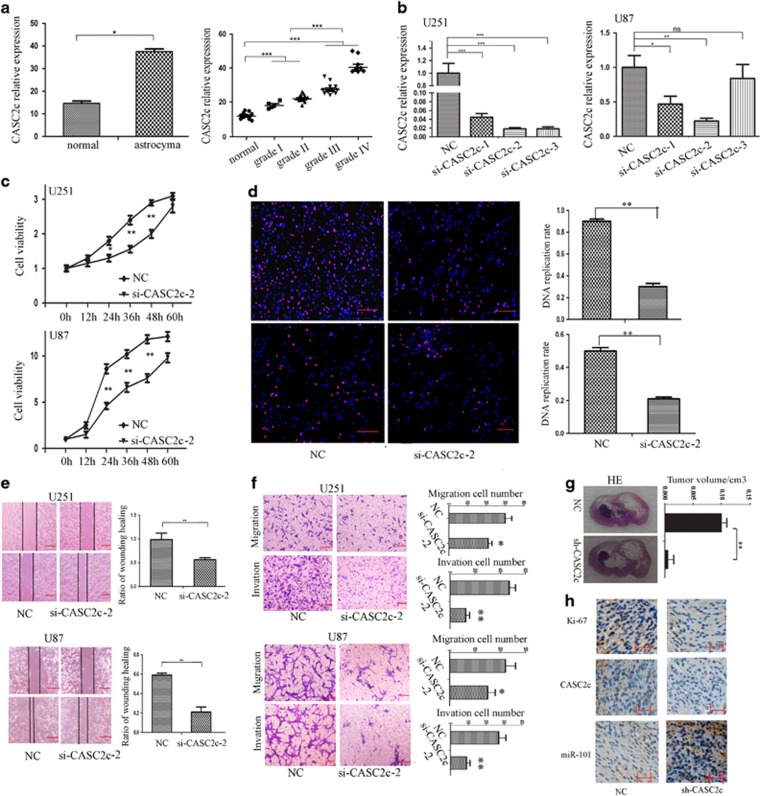
CASC2c is correlated with tumorigenicity and progression in astrocytoma. (a) Left, the expression of CASC2c in normal brain tissues and astrocytoma was determined by real-time qPCR. Data presented as mean±S.E.M. of three independent experiments; *P<0.05. Right, the level of CASC2c in different status of pathology classification was measured by real-time qPCR. Data presented as mean±S.E.M. of three independent experiments; ***P<0.001. (b) CASC2c expression level was evaluated using real-time qPCR in nc/si-CASC2c-transfected U251 and U87 cells. Data presented as mean±S.E.M. of three independent experiments; *P<0.05, **P<0.01, ***P<0.001. (c) CCK8 assay was performed to determine the viability of U251 and U87 cells that transfected nc/si-CASC2c-2.Data shown are the mean ±S.E.M. of three independent experiments; *P<0.05, **P<0.01. (d) EDU assay was applied to assess cell proliferation of U251 and U87 cells that transfected nc/si-CASC2c-2. Data shown are the mean±S.E.M. of three independent experiments; red scale bars, 200 μm; **P<0.01. (e) Wound healing assay measured cell migration of U251 and U87 cells that transfected nc/si-CASC2c-2. Data shown are the mean±S.E.M. of three independent experiments; red scale bars, 200 μm; **P<0.01. (f) Transwell assay and matrigel-coated transwell assay were performed in U251 and U87 cells that transfected si-CASC2c-2. Data shown are the mean±S.E.M. of three independent experiments; red scale bars, 50 μm; *P<0.05, **P<0.01. (g) H&E staining of shCAS2c-induced tumors in the coronal section of rats. **P<0.01. (h) The expression of CASC2c and miR-101 in intracranial-transplanted tumors were detected by in situ hybridization, the expression of Ki-67 in intracranial-transplanted tumors were detected by immunohistochemical staining. Scale bars, 200 μm